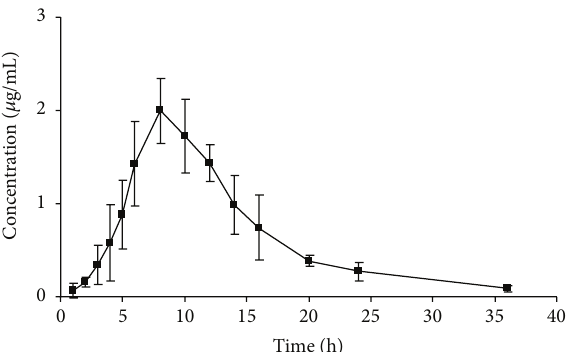
Figure 3: Mean ( ± S.D.) plasma concentration-time profile of ergosterol in the plasma of healthy rats ( 𝑛 = 6 ) that were administered a single oral dose of 100mg/kg of ergosterol.